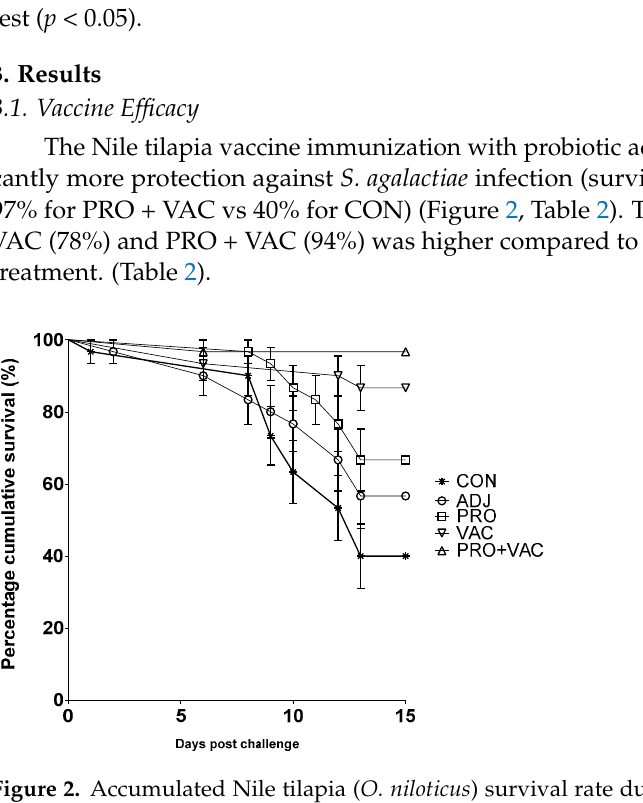
Figure 2. Accumulated Nile tilapia ( O. niloticus ) survival rate during 14 days of S. agalactiae challenge infection (CON: control; ADJ: adjuvant; PRO: probiotics; VAC: vaccinated; PRO + VAC: probiotics + vaccine).